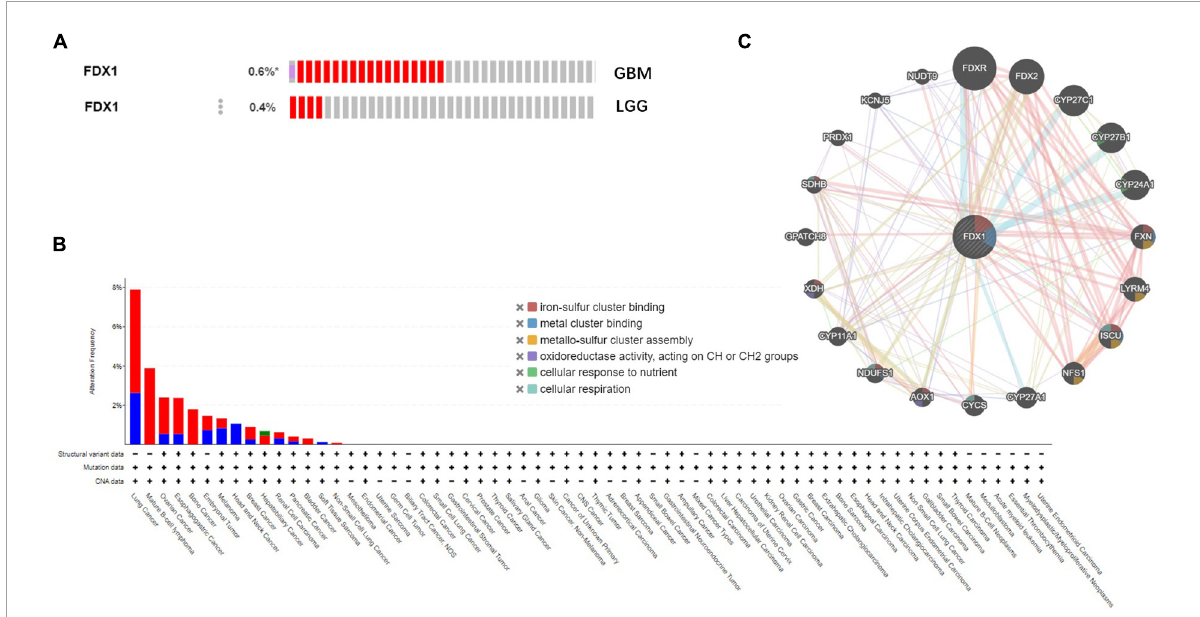
FIGURE5 Genetic alterations and interactions of FDX1 gene in glioma. (A) Genetic alterations of FDX1 gene in cBioPortal database. (B) Mutation frequency of FDX1 gene in GBM and LGG samples. (C) Interaction network analysis of FDX1 gene was performed by GeneMANIA.